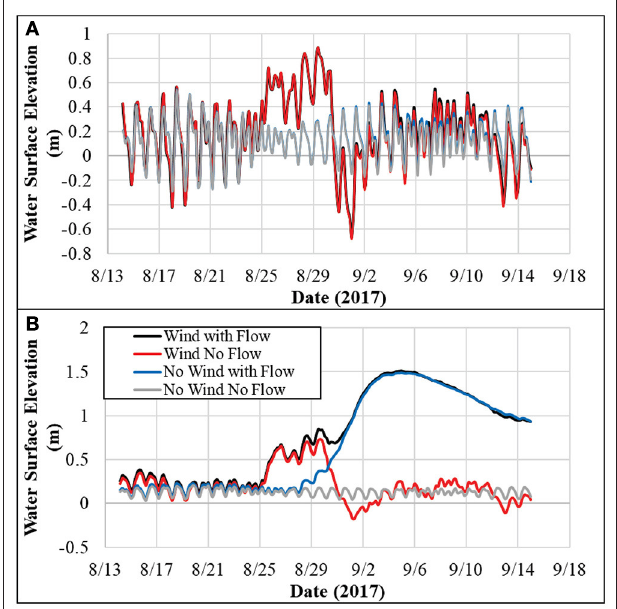
FIGURE 4 | Water surface elevations from ADCIRC with various forcing conditions turned on/off (A) just downstream of the Sabine Lake at its confluence with Gulf of Mexico, and (B) at the confluence of Neches River and Sabine Lake (HEC-RAS and ADCIRC small mesh downstream boundaries).